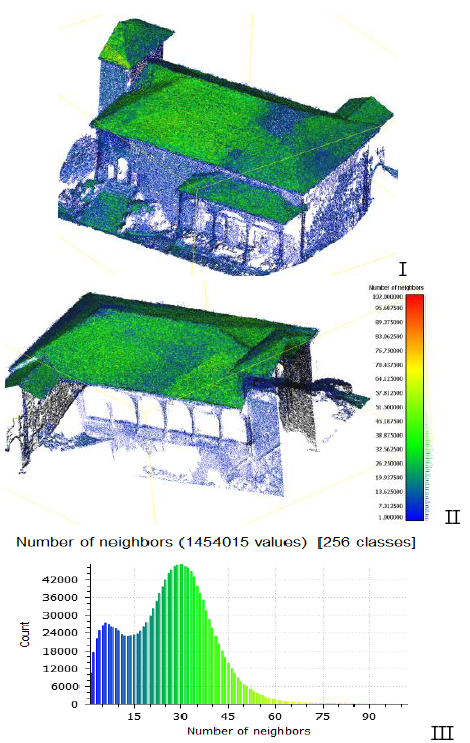
Figure 14. Density analysis of the Photoscan (I) and the VisualSfM (II) cloud.